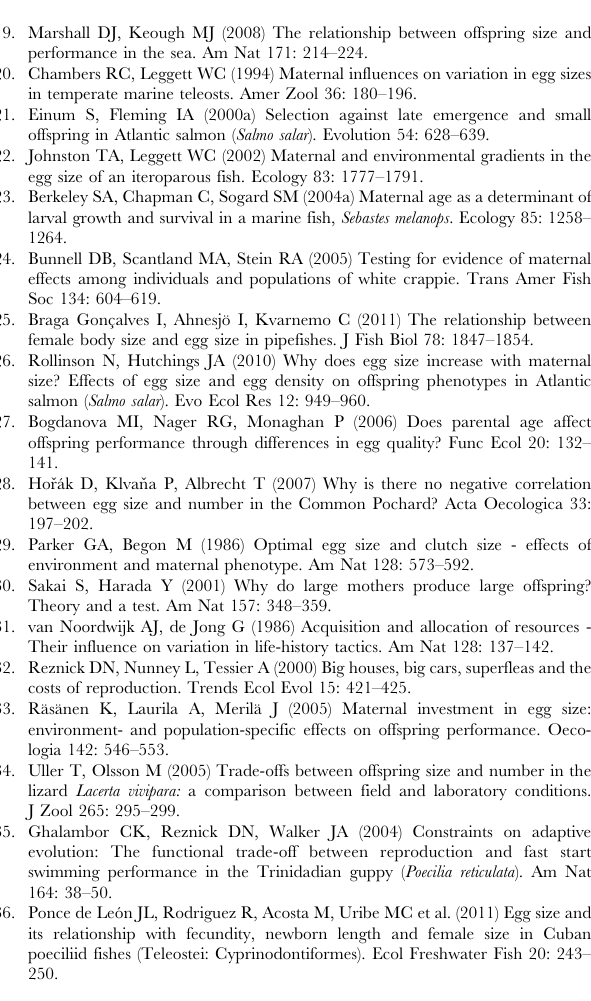
Figure S1 Size, age, and condition of mature females are positively related. Data are pooled across sites and years; to indicate depth, the point color shifts from red to